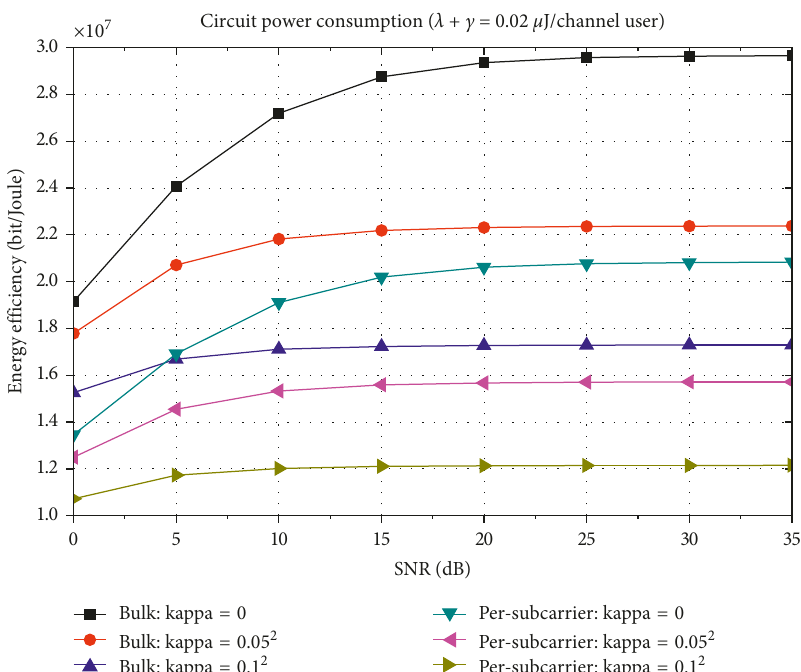
Figure 6: Energy efficiency of the massive MIMO-OFDM channel versus the SNR for per-subcarrier selection and bulk antenna selection techniques using various hardware impairments (kappa